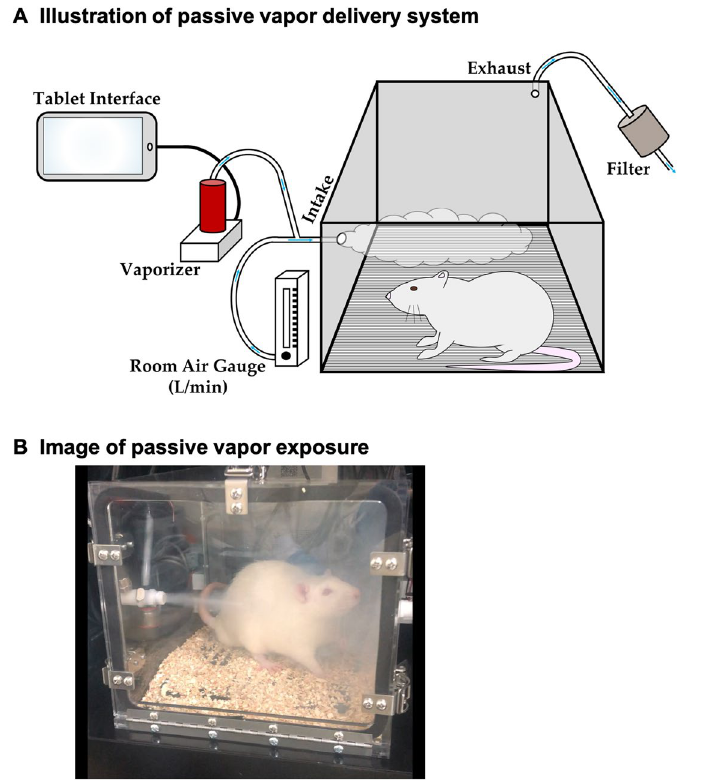
Figure 1. Vapor delivery system. ( A ) Illustration of passive vapor delivery system: Schematic of vapor apparatus components with direction of air-flow (adapted from Freels et al. 5 ). Briefly, the vapor inhalation system